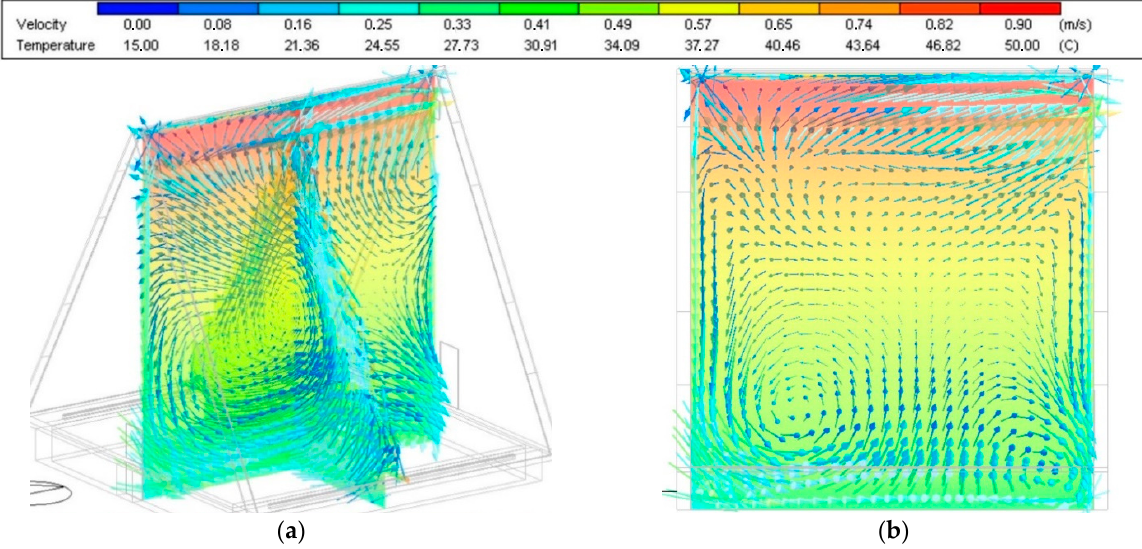
Figure 9. Simulated airflow paths on 6.6. at 12:00 a.m. in position of: ( a ) transverse sections; ( b ) longitudinal section.